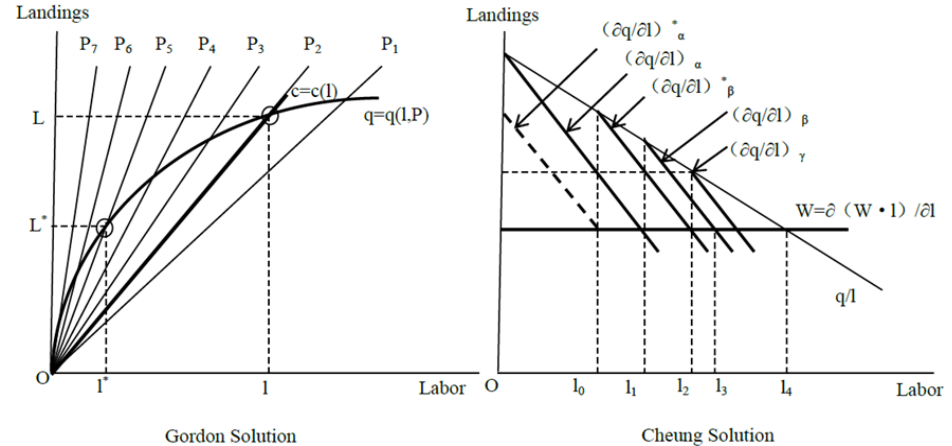
Figure 1. Traditional Rent Dissipation Models: Biological Population versus Common Property. “l * ” in the Gordon Solution suggests optimal labor input. Geometrically, this point can be found by moving the cost curve c = c(l) parallelly to get a point of tangency in production function q = q(l, P). To rephrase it, we shall say marginal equality principle prevails in this land use case.